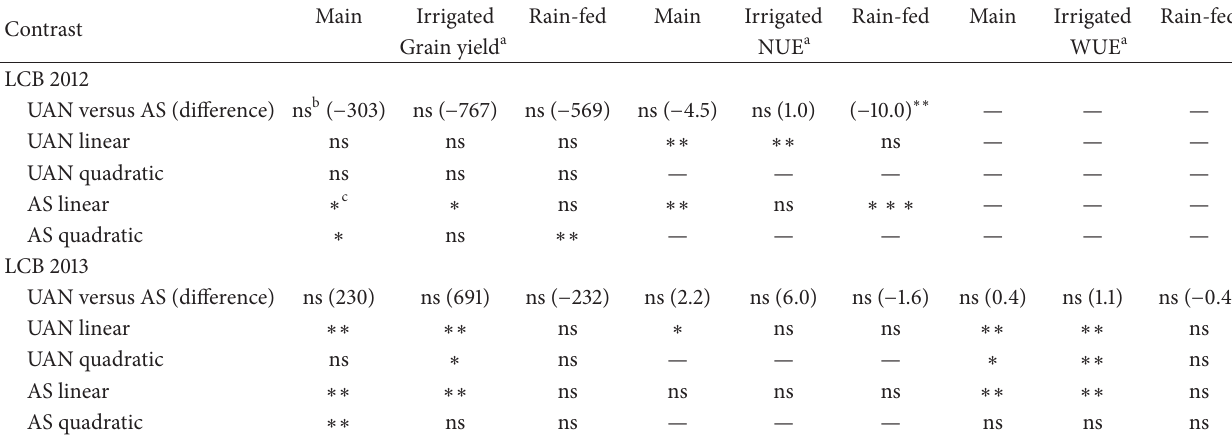
Table 7: Single degree-of-freedom contrast results for differences in treatment groupings for grain yield, N use efficiency (NUE), and water use efficiency (WUE) for Lake Carl Blackwell, OK (LCB), in 2012 and 2013. Results listed under the “Main” column heading are the results of data pooled across irrigated and rain-fed treatments. Values in parenthesis are the difference in mean values for the group after the “versus” subtracted from the mean value of the group before the